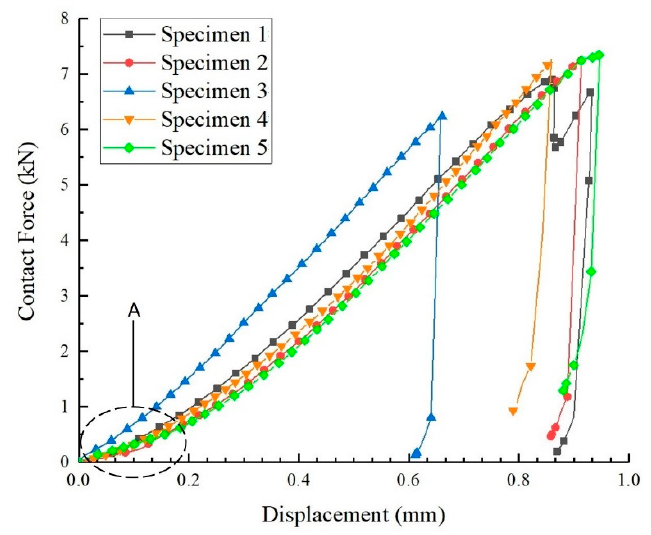
Figure 4. Force–displacement relationship in ball–plane contact compression test.